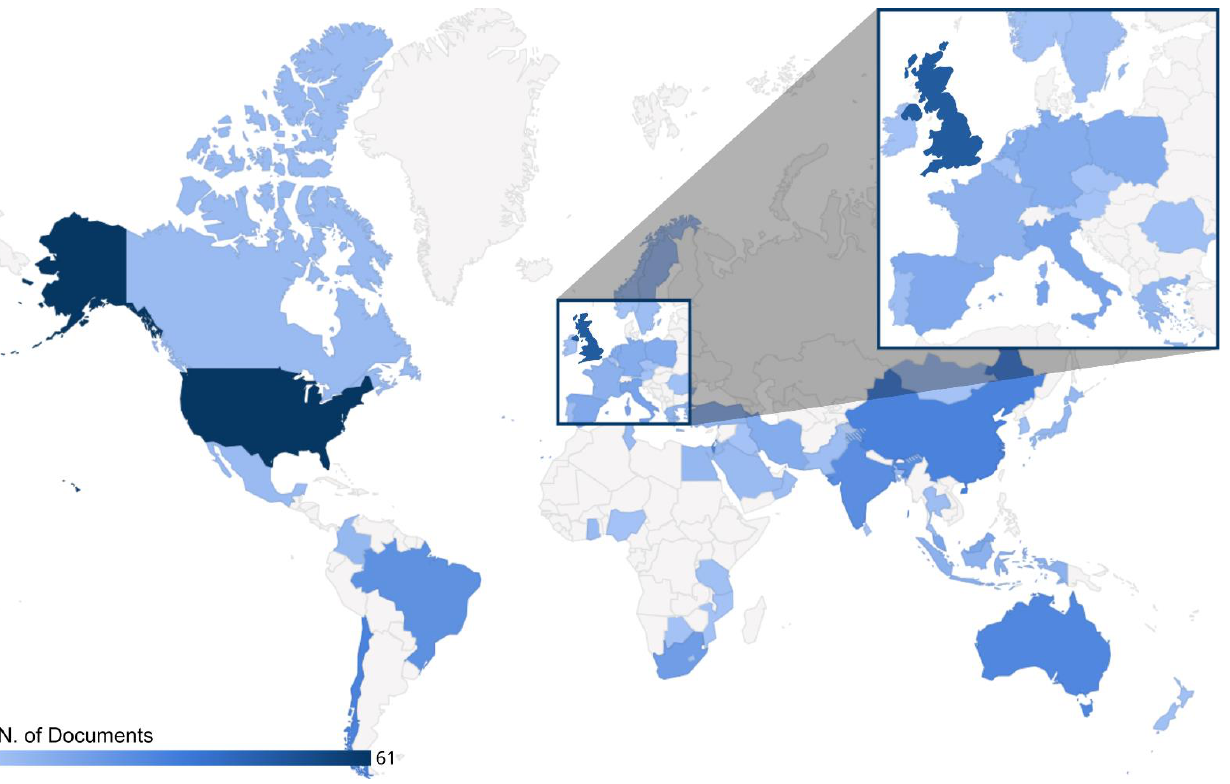
Figure 11. Global geographic distributions of publications in greywater recycling domain during the period from 2001 to 2022.